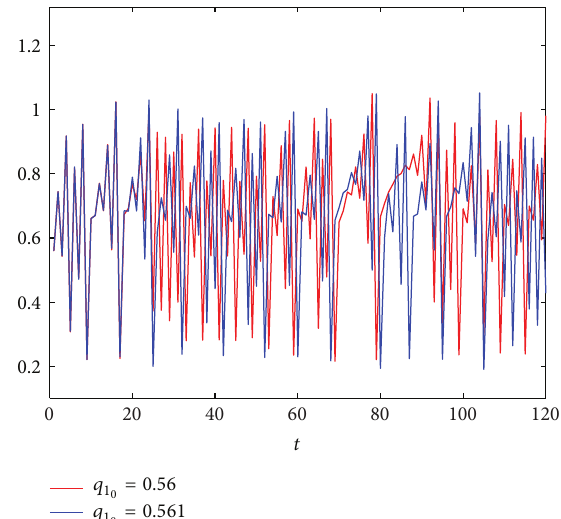
Figure 20: For 𝛼 1 = 1.32 , 𝛼 2 = 2.471 and 𝜃 = 0.5 , and the initial conditions which are (0.76, 0.92) and (0.76, 0.921), the history diagram with the change of time about the output 𝑞 2